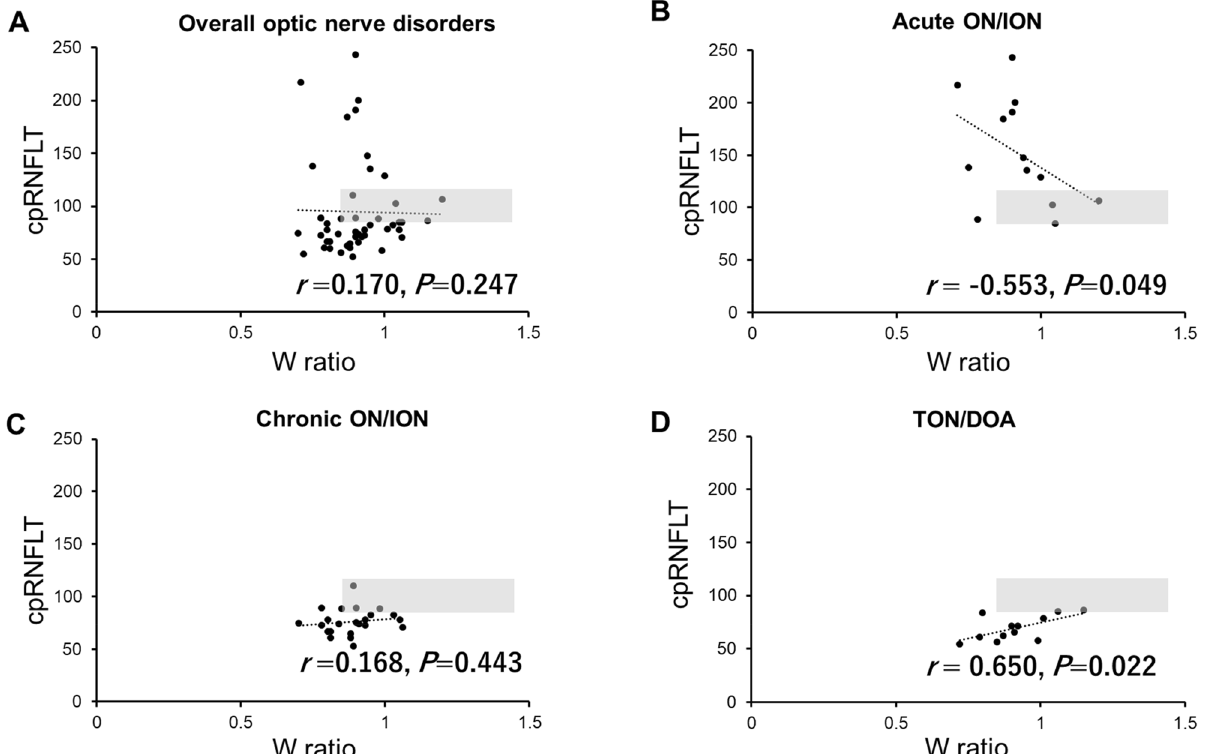
Figure 2. Graph showing the relationship between the W ratio and cpRNFLT in optic nerve disorders. Scatterplots of all of the cases of optic nerve disorders ( A ), acute phase of optic neuritis, and ischemic optic neuropathy ( B ), chronic phase of optic neuritis or ischemic optic neuropathy ( C ), dominant optic neuropathy or traumatic optic atrophy versus cpRNFLT ( D ). The gray areas in the scatterplot show the distribution of data for normal